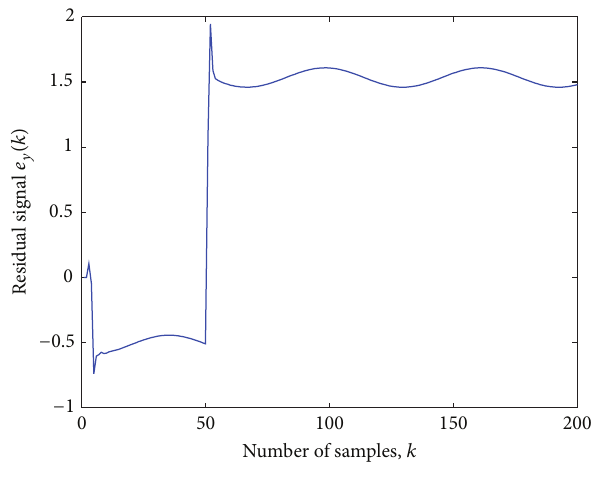
Figure 2: System residual signal with fault. Figure 3: Fault detection with stochastic uncertainties and time